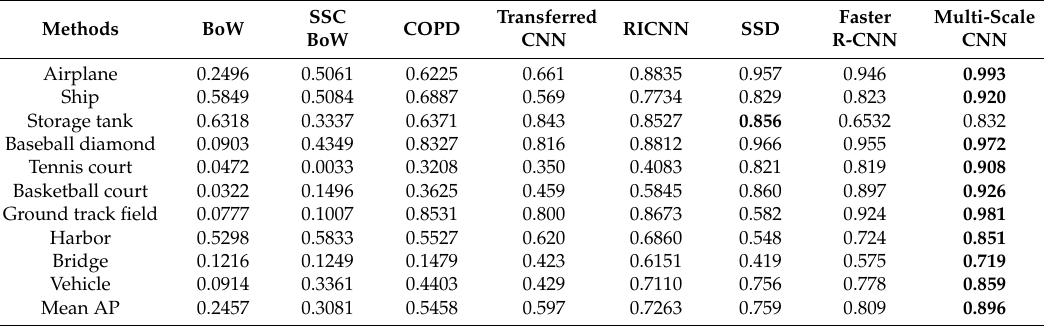
Table 4. The AP values of the eight object detection methods.